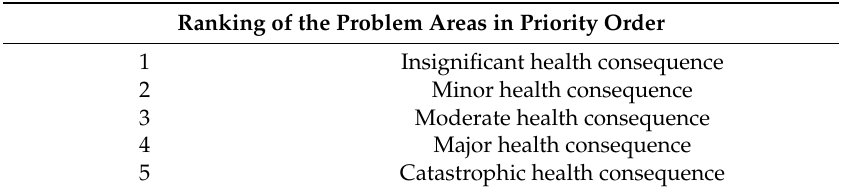
Table 1. Ranking of the problem areas in priority order.